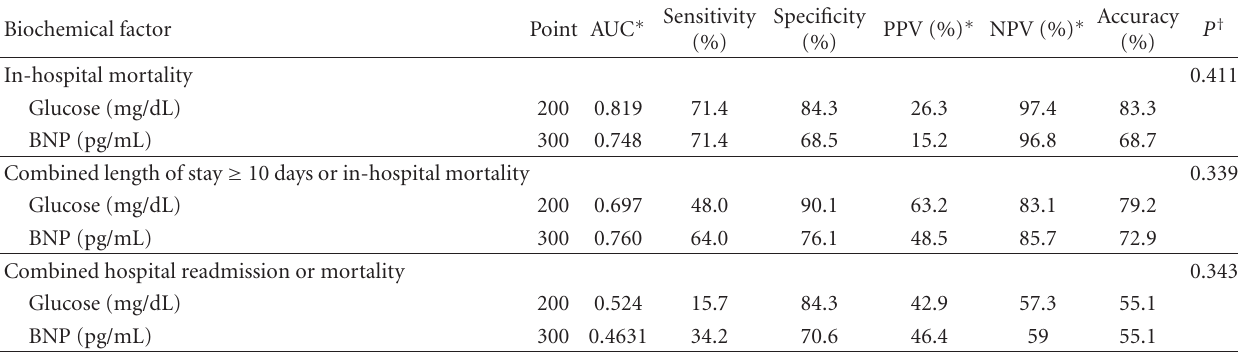
Table 3: Comparison of BNP and blood glucose in outcome predictions. Area under the curve, sensitivity, specificity, positive predictive value, negative predictive value, and accuracy.